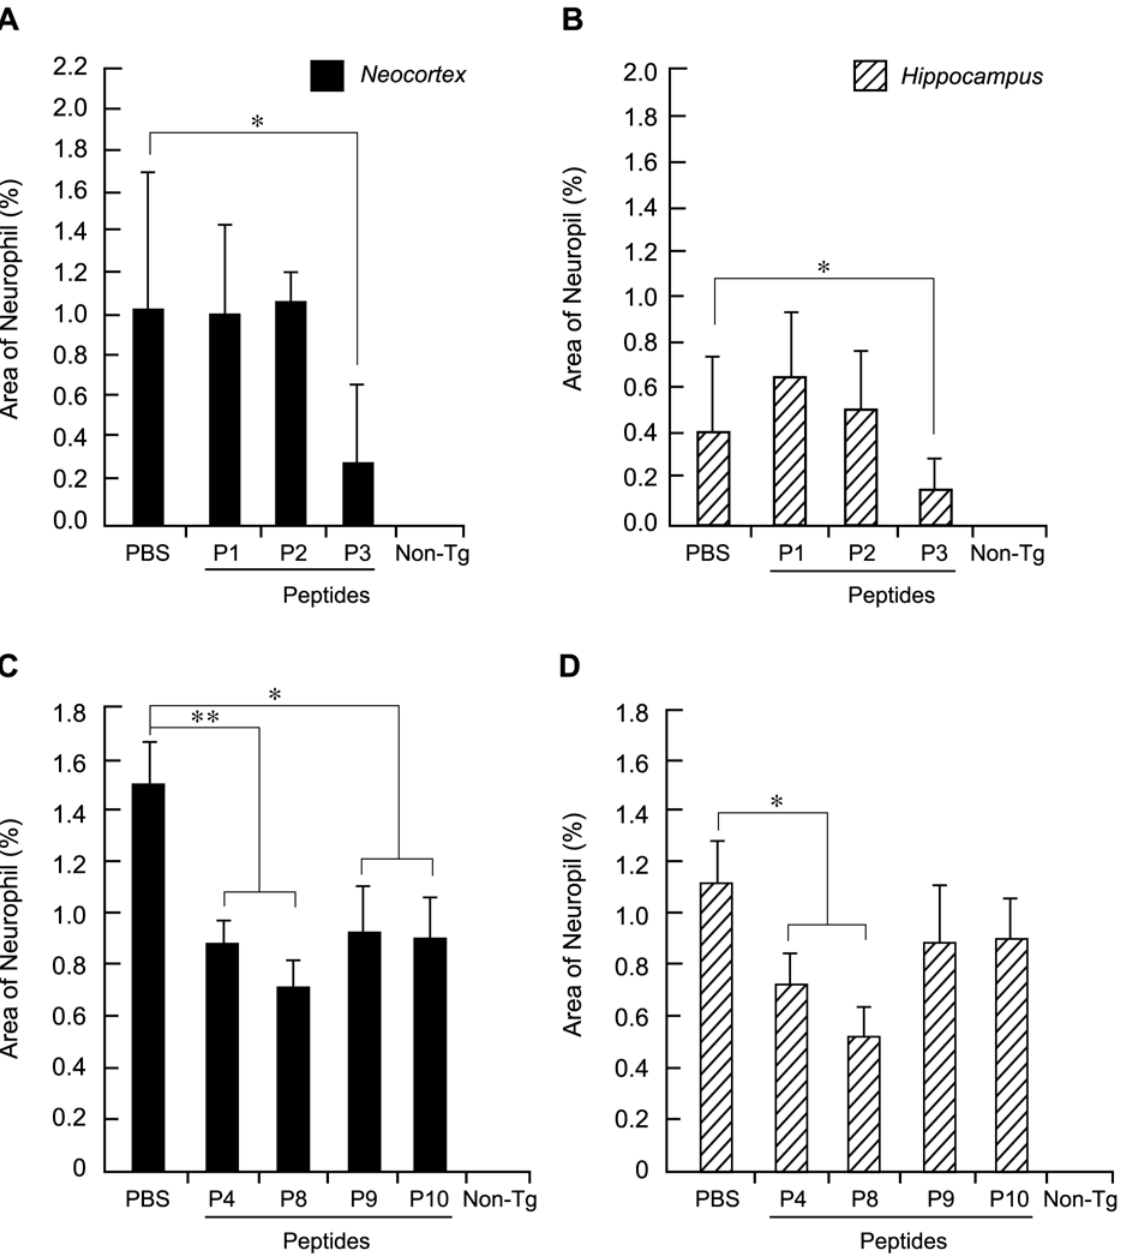
Fig 2. Effects Of Peptides P1 Through P10 Infusion In Brains Of mThy1-hAPP Mice on Plaque load. Effects of Peptides P1 – P3 (A and B) and P4 – P10 (C and D): Quantification of plaque load in neocortex (A and C) and hippocampus (B and D). A β - immunoreactive deposits were imaged and digital images were analyzed to determine the percent area of the neuropil occupied by A β . Three immunolabeled sections were analyzed per mouse and the average of individual measurements was used to calculate group means. Values represent group means ± s.e.m. * , p < 0.05; ** , p < 0.005 versus PBS by ANOVA.